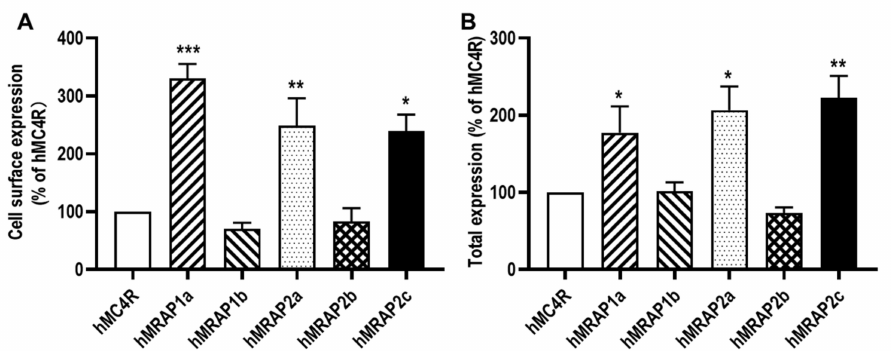
Figure 5. Regulation of hMC4R expression by hMRAP1s or hMRAP2s. Cell surface ( A ) and total ( B ) expression of hMC3R were measured by flow cytometry. HEK293T cells were co-transfected with hMC3R and hMRAP1s or hMRAP2s. Fluorescence in cells transfected with empty vector pcDNA3.1 was used for background staining. The results are calculated as % of 1:0 group. Each data point represented the mean ± SEM (n = 3). * indicates significant difference ( * p < 0.05, ** p < 0.01, and *** p < 0.001) (one-way ANOVA followed by Tukey test).